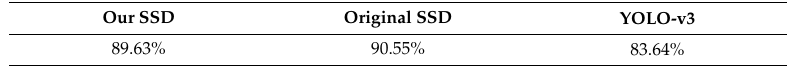
Table 3. Comparison of the mean Intersection Over Union (IoU) for the three methods.